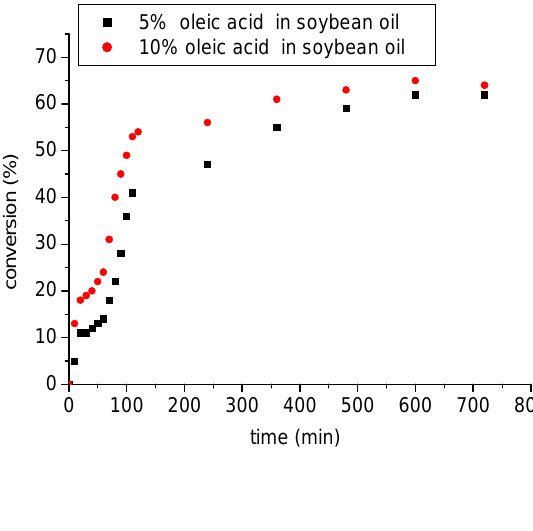
Figure 8 . Esterification of soybean oil with high amounts of oleic acid catalyzed by SnCl 2